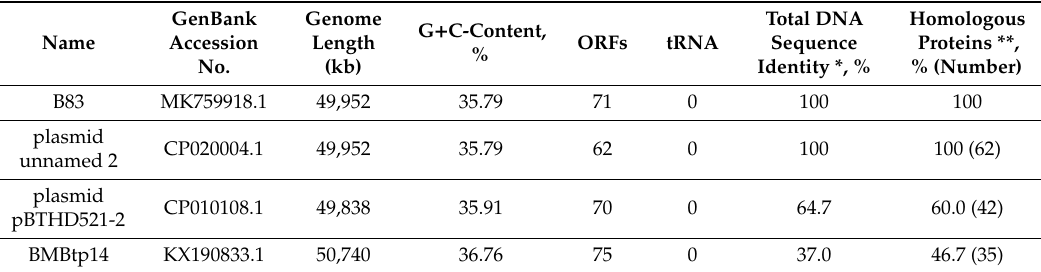
Table 2. The properties of B83 and the most closely related